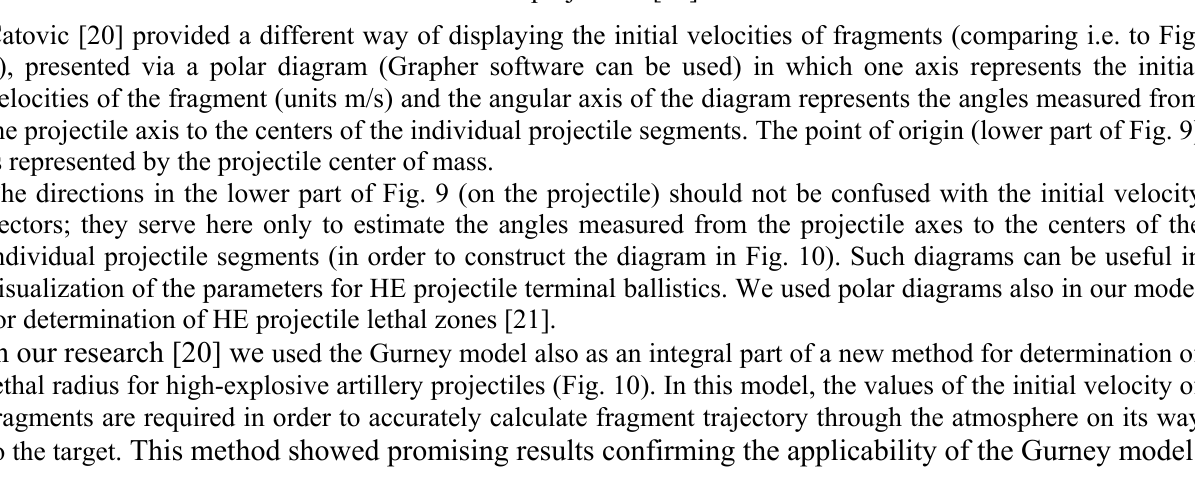
Figure 8. Influence of projectile design on the values of the initial velocity of fragments for several types of HE projectiles